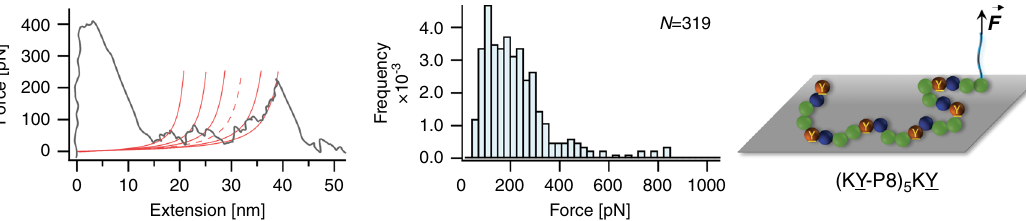
Fig. 6 SMFS results of (KY-P8) 5 KY peptide interacting with TiO 2 . Representative F – X curve and rupture force distribution for the interaction of the peptide with the surface are shown. The retraction trace is smoothed using a 10-period moving-average fi lter to reduce the thermal noise. N value represents the total number of rupture events used to plot the histogram. The red lines in F – X curve show WLC fi ttings, where dashed line corresponds to the missing rupture peak. Right column shows schematic illustration of the peptides interacting with the substrate where green spheres represent the oligoethylene glycol spacer between the KY units. Source data are provided as a Source data fi